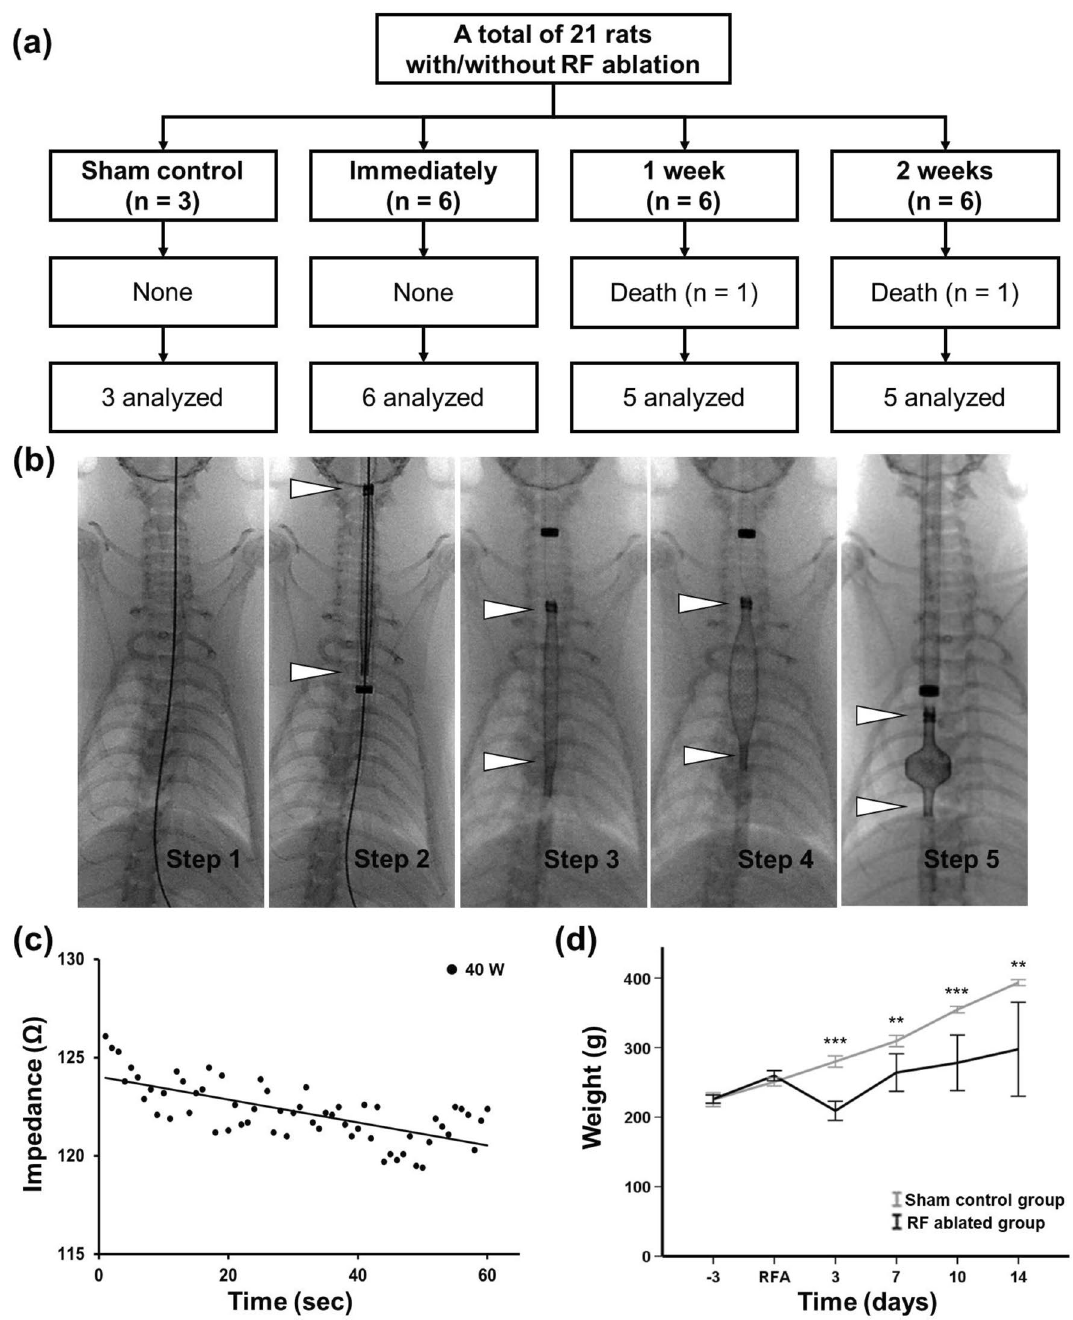
Figure 4. In-vivo experimental design, impedance, and weight changes. ( a ) Flow diagram of the in-vivo study design and follow-up. ( b ) Radiographic images showing the technical steps for the radiofrequency (RF) ablation using a stent-based monopolar RF electrode (SE) in the rat esophagus. Step 1, a micro guidewire was inserted through the esophagus into the stomach; step 2, a SE loaded delivery system ( arrowheads ) was advanced over the guidewire; step 3, the olive tip of the SE ( arrowheads ) was placed at the margin of the diaphragm under fluoroscopic guidance; step 4, the adjustable SE ( arrowheads ) was deployed with a diameter of 4 mm and a length of 3 mm to fully attach the electrode to the entire inner wall of the rat esophagus. ( c ) Impedance changes during RF ablation at 40 W for 60 s in the rat esophagus. ( d ) The body weight changes after RF ablation. * p < 0.05, ** p < 0.01, *** p <